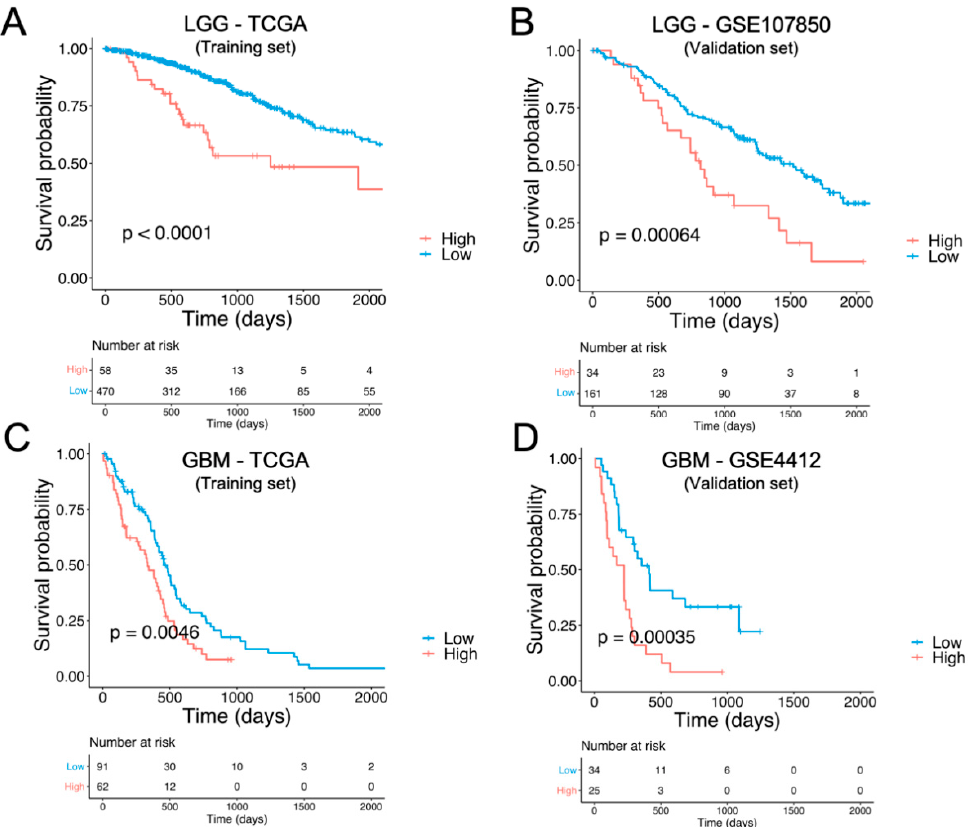
Figure 4. Prognostic value of the NTR gene signatures and their validation. ( A ) The overall survival (OS) curve of the gene signature generated using the LGG-NTR prognostic genes shown in Figure 3B. Blue and red KM curves represent the predicted low-risk and high-risk groups, respectively. The log-rank p -value and the number of patients at risk are shown for each risk group. ( B ) OS curve of the gene signature identified using the TCGA-LGG dataset in a GEO-independent dataset (GSE107859). ( C ) OS curve of the GBM-NTR gene signature generated by using the TCGA-GBM prognostic genes shown in Figure 3B. ( D ) OS curve of the gene signature identified using the TCGA-GBM dataset in a GEO-independent dataset